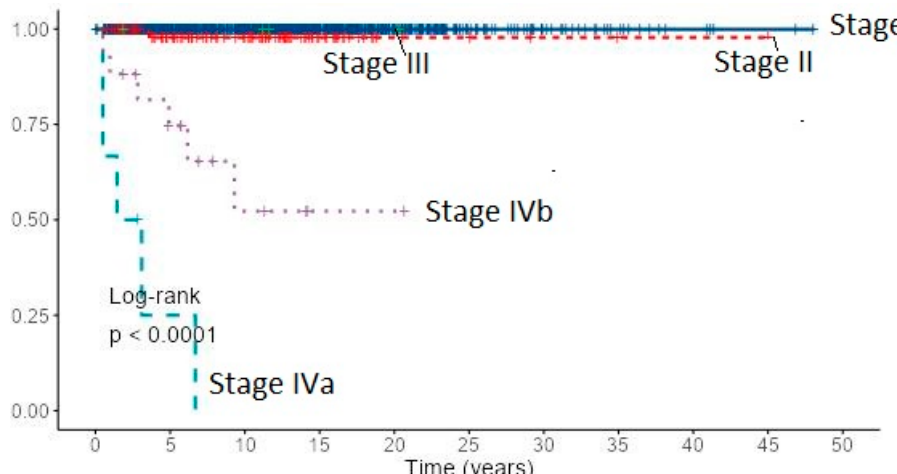
Figure 6. Cancer-specific survival of 1167 patients with PTC by the AJCC/UICC TNM staging system (8th edition) based on Kaplan–Meier estimates.